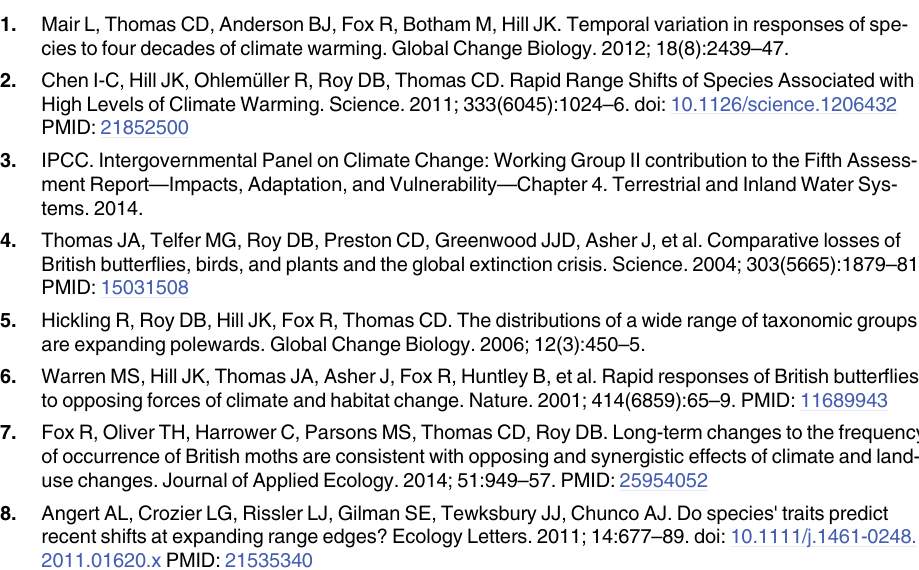
S4 Table. Moran ’ s I phylogenetic autocorrelation indices and associated p-values. S5 Table. Impacts of species traits on distribution changes of British grasshoppers and crickets (all species), phylogenetic models. S6 Table. Amount of overall variation explained by models (adjusted deviance D 2 ). S7 Table. Impacts of species traits on distribution changes of British grasshoppers and crickets (excluding Conocephalus discolor and Metrioptera roeselii ), phylogenetic models. S8 Table. Fitted range change